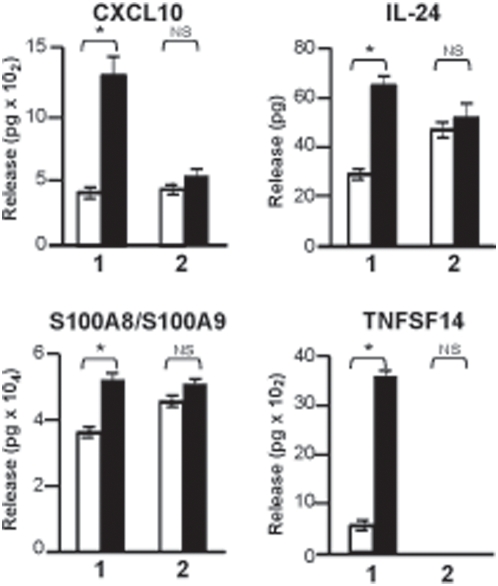
Release of cytokines of the innate immune response by TG cells.Wild type TG and CF-TG cells (2×106 cells per assay) were incubated in the absence (white bar) or presence (black bar) of P. aeruginosa-secreted products for 24 h. The release of cytokines of the innate immune response by wt TG cells (1) and CF-TG cells (2) was determined by ELISA. The results are expressed in pg of cytokines. They represent means±SEM of three experiments. *P<0.05. NS: non significant.